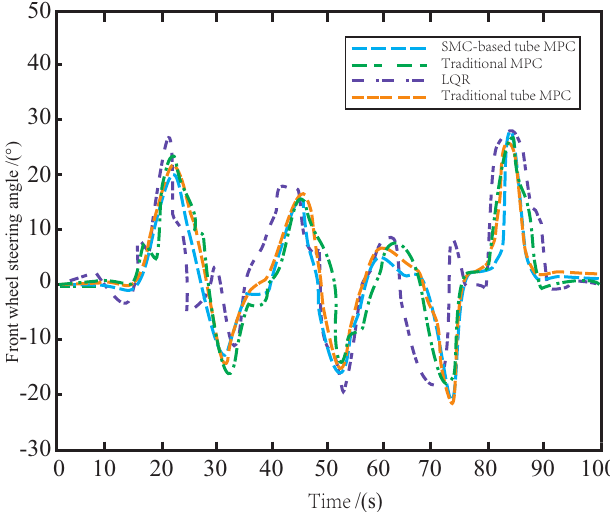
Figure 11. The variation of front wheel angle on the icy